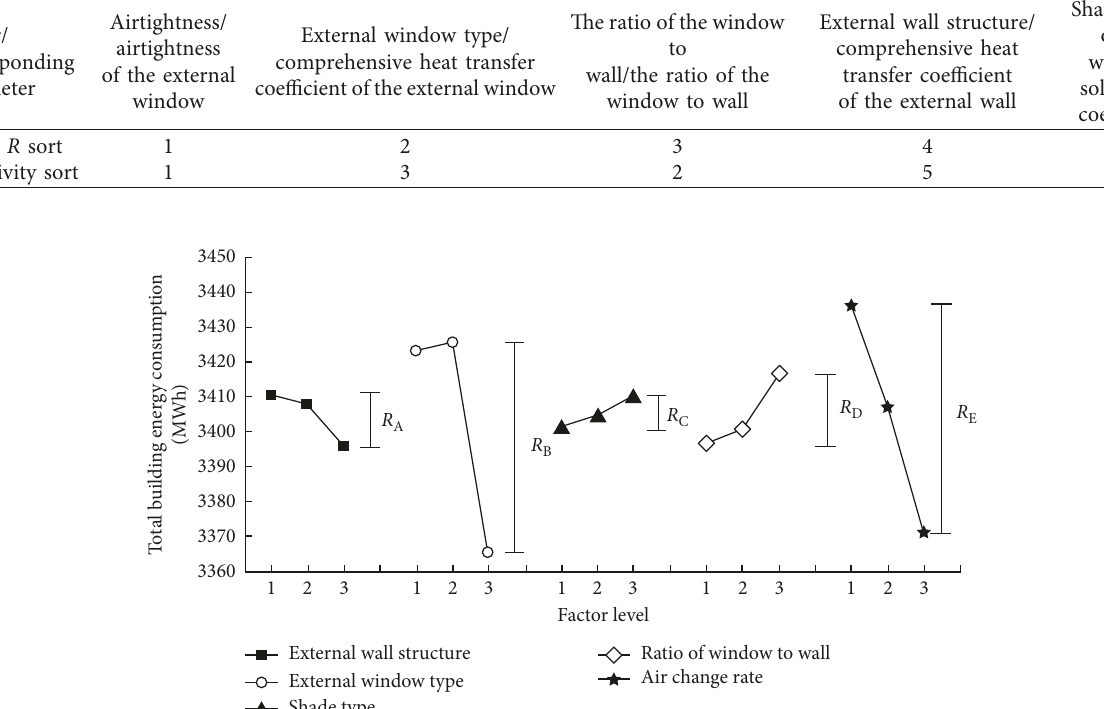
Figure 10: Influence of the different levels of the enclosure structure on the total building energy consumption in public